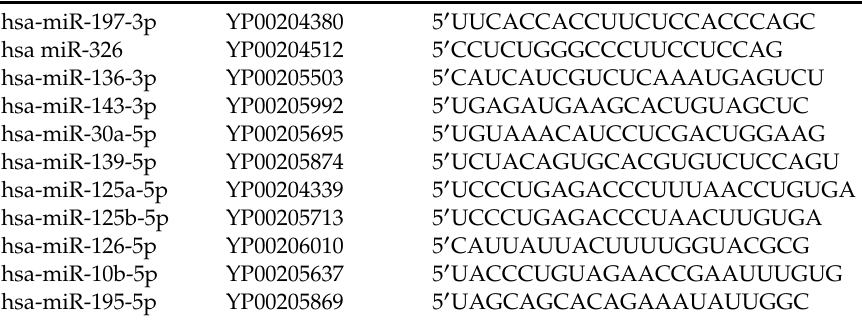
Table A2. miRCURY LNA miRNA PCR assays for screening